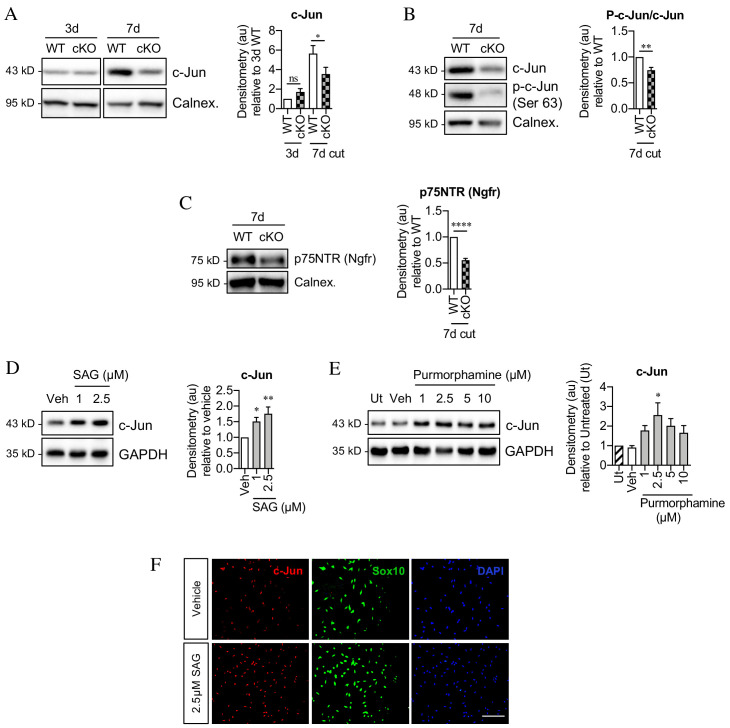
Sonic hedgehog promotes c-Jun activation in Schwann cells in vivo and in vitro.(A) Representative western blot showing c-Jun expression in WT and Shh cKO (cKO) nerves 3 and 7 days after cut. Quantitation is shown in the graph where the data are normalized to WT 3 days post-cut. Two-way ANOVA with Sidak’s test; *p<0.05. n = 5 for each genotype. (B) Representative Western blot showing c-Jun and phosphorylated c-Jun (p-c-Jun) in WT and Shh cKO distal nerve stumps 7 days post-cut. Quantitation is shown in the graph where the data are normalized to WT 7 days post-cut. Unpaired Student’s t-test; **p=0.0014, n = 5 for each genotype. (C) Representative western blot showing p75NTR protein in WT and Shh cKO nerves 7 days post-cut. The graph shows quantitation of the results. Data are normalized to WT 7 days post-injury. Unpaired Student’s t-test; ****p=<0.0001. n = 5 for each genotype. (D) Representative western blot showing c-Jun in Schwann cell cultures exposed to SAG for 48 hr. (Veh: DMSO vehicle). Quantitation is shown in the graph where the data are normalized to vehicle. One-way ANOVA with Dunnet’s test; *p<0.05, **p<0.005. n = 6. (E) Representative western blot showing c-Jun in Schwann cell cultures exposed to purmorphamine for 48 hr. Quantitation is shown in the graph where the data are normalized to vehicle. One-way ANOVA with Dunnet’s test; *p<0.05. n = 3. (F) Representative immunofluorescence images showing increased c-Jun labeling of Sox10-positive Schwann cell nuclei after 48 hr incubation with SAG compared to vehicle (DMSO). Scale bar: 100 µm.